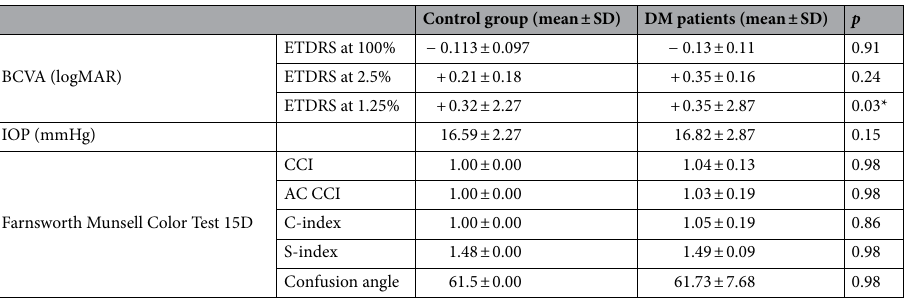
Control group (mean ± SD) DM patients (mean ± SD)